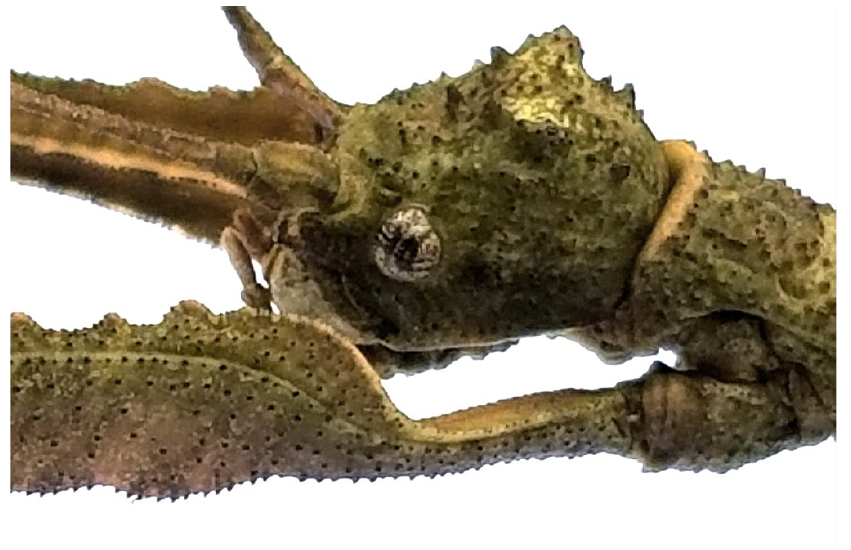
Figure 8. Head in lateral view, total length 9 mm, showing the vertex with prominent tubercles and details of the femur.